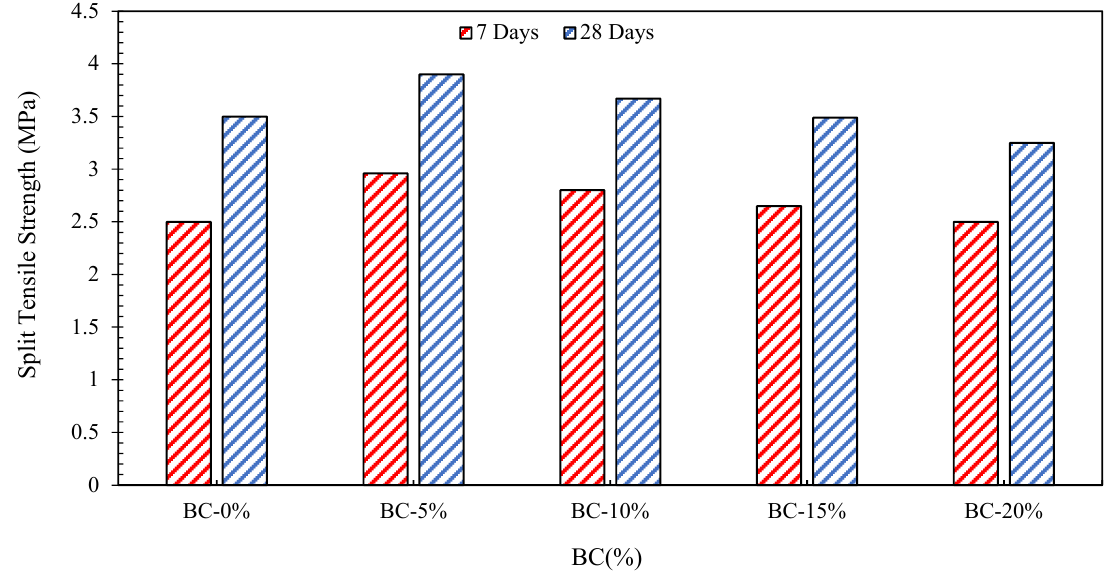
Figure 7. Split tensile strength (data source [58]).